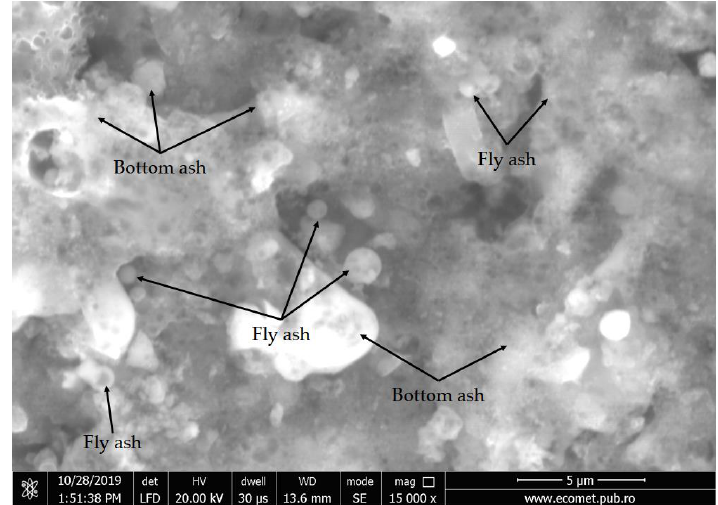
Figure 1. Coal ash morphology showing bottom and fly ash particles.